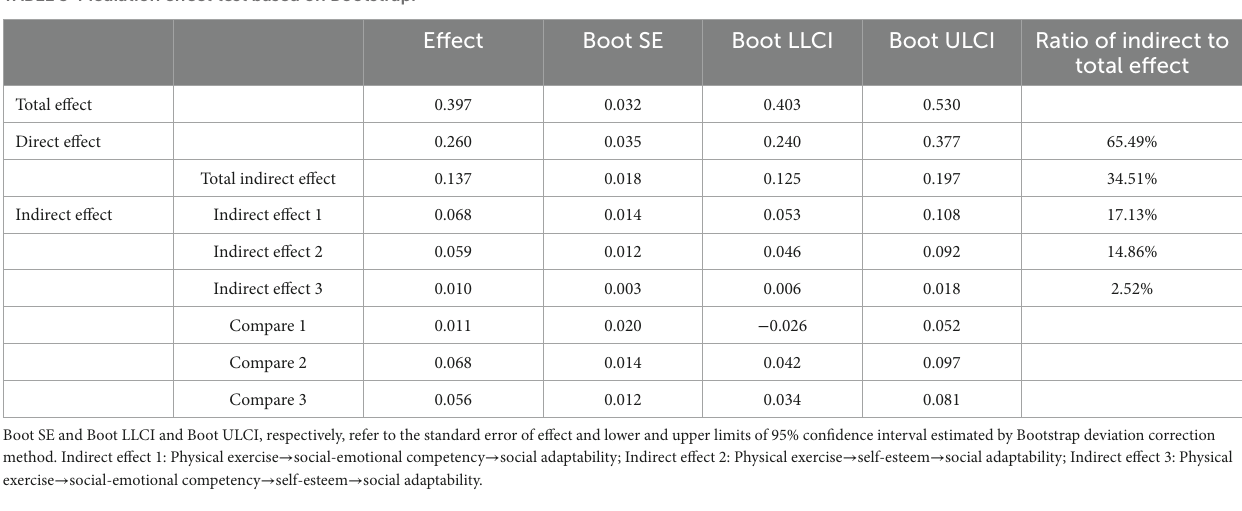
TABLE 3 Mediation effect test based on Bootstrap.